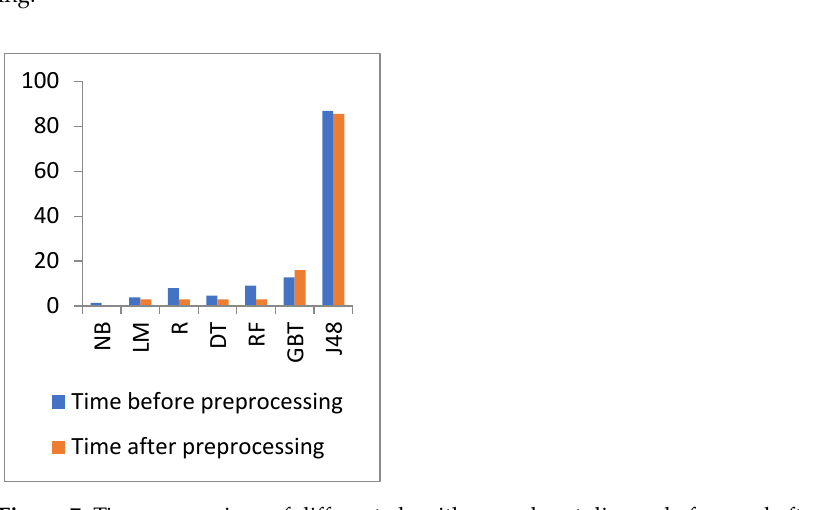
Figure 6. Accuracy comparison of different algorithms on heart disease before and after prepro- cessing.